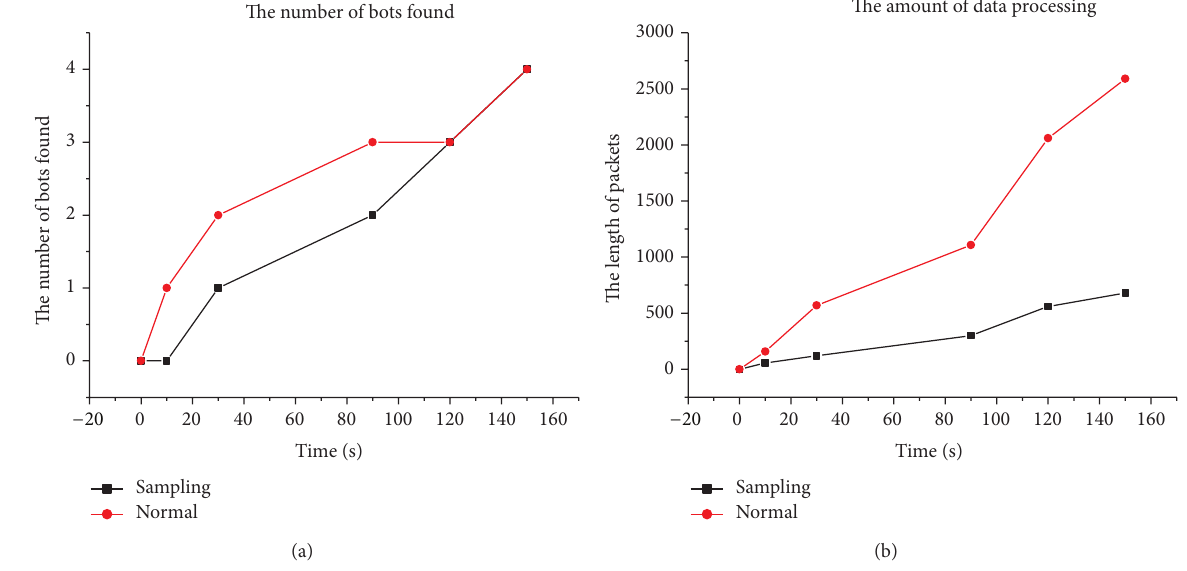
Figure 5: Bots detected in different time windows and data processed for detection.